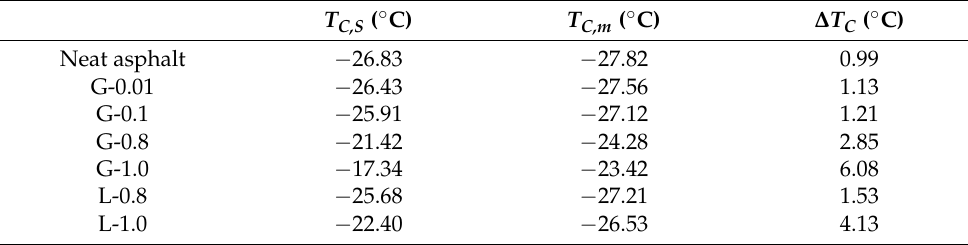
Table 6. Critical temperatures of different